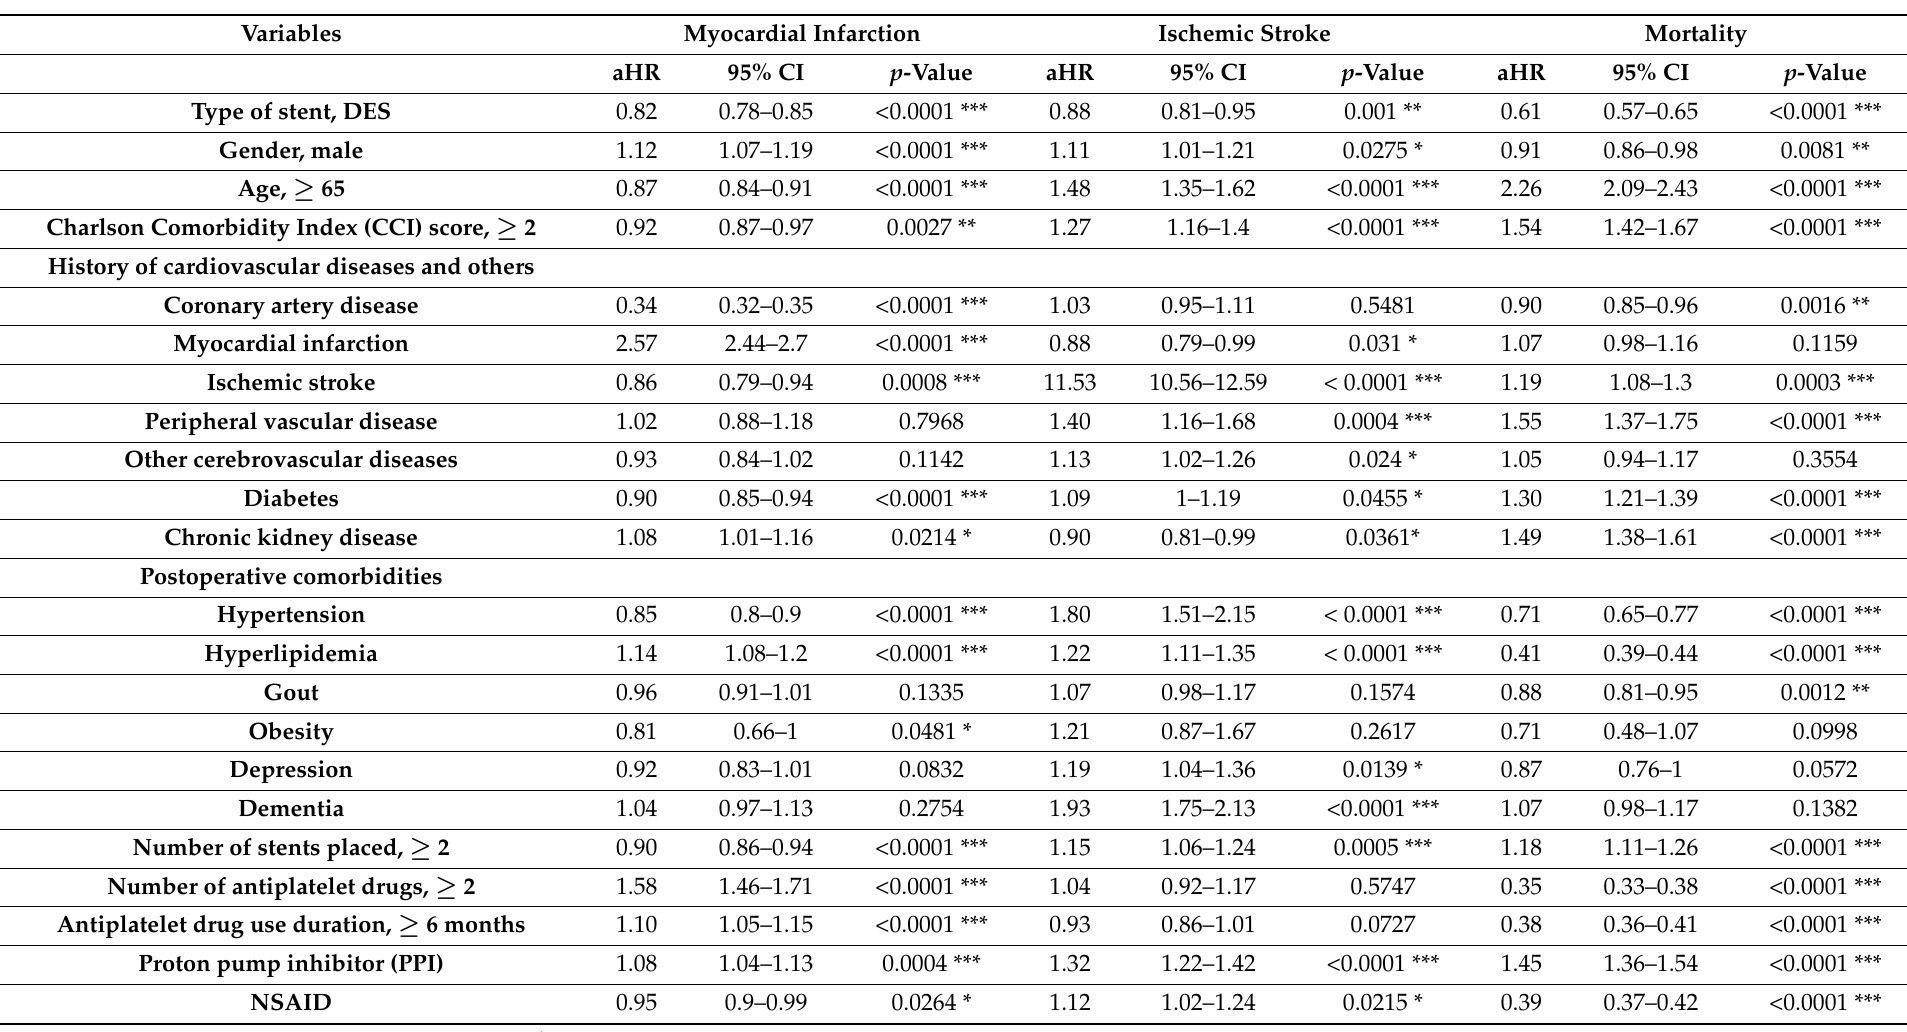
Table 2. Results of the Cox proportional hazard